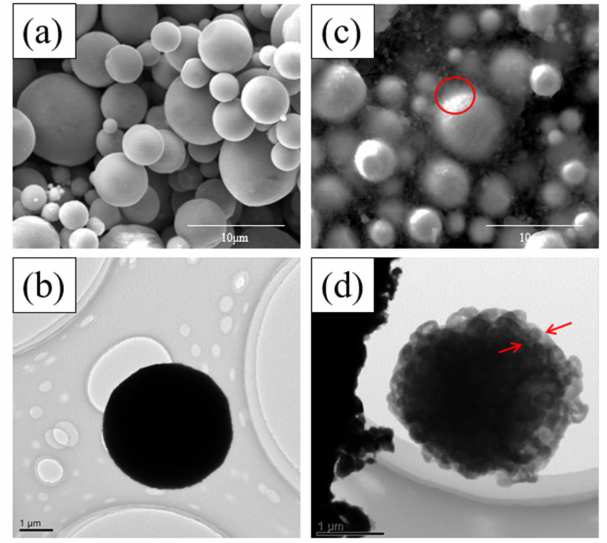
Figure 3. ( a ) SEM image of pristine zinc powders. ( b ) TEM image of the single zinc particle with smooth surface. ( c ) SEM image of the WB zinc-based coating. ( d ) TEM image of an individual zinc particle encapsulated by a shell consisting of silane-crosslinked potassium silicate and